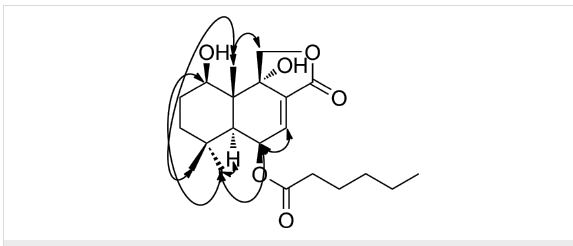
Figure 3: NOESY correlations of